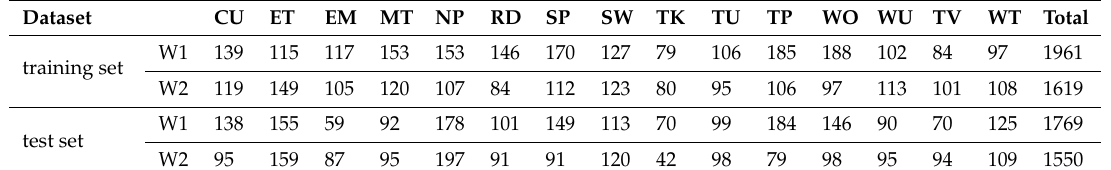
Table 2. Number of images in the training and test sets.